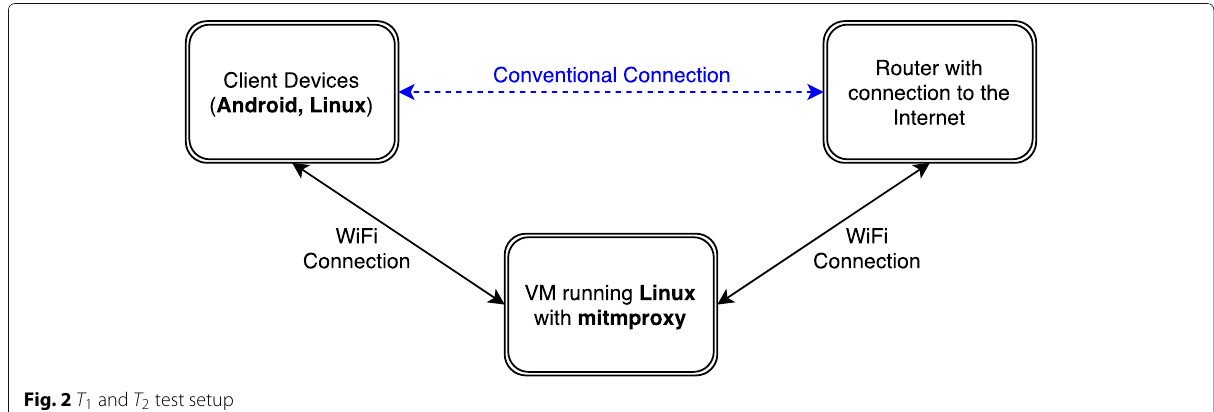
Fig. 2 T 1 and T 2 test setup